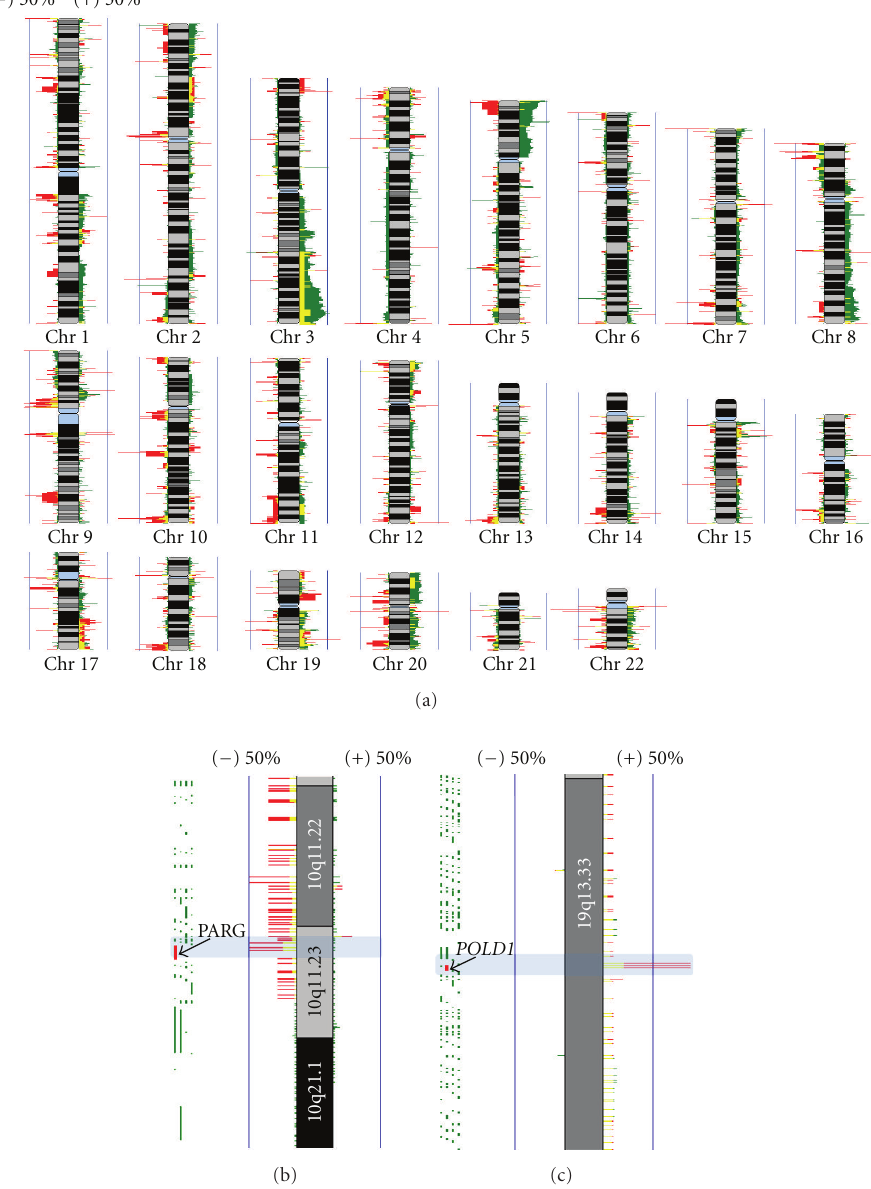
Figure 1: Genome-wide identification of arsenic-related and smoking independent DNA copy number alterations in lung squamous cell carcinoma (SqCC). Genomic copy number profiles for lung SqCC biopsies ( n = 52) were obtained using whole genome aCGH. SqCC tumors from smokers ( n = 42), comprised ( n = 30) samples from North American with no known arsenic exposure, and ( n = 12) samples from Northern Chile from individuals chronically exposed to arsenic. SqCC tumors from never smokers ( n = 10) were from chronically arsenic- exposed individuals from Northern Chile. (a) Frequency plot of arsenic-related and smoking independent copy number di ff erences in SqCC. The frequency of DNA gain/loss for each probe was calculated and plotted for each group, where smokers (dark green) and never smokers (red). Regions exhibiting similar alteration in both groups are denoted in yellow. The magnitude of green and red bars represents percent alteration for each probe per group (0–100%, with blue vertical lines representing 50% frequency). DNA gains and losses are represented to the right and left of each chromosome, respectively. Analysis was restricted to autosomes, with any di ff erences based on sex subtracted from further analysis. A high frequency of copy number alteration, previously undescribed for SqCC were evident in arsenic exposed tumors from never smokers, particularly for chromosome 3q. (b) Detail of DNA losses at 10q11.23 specific to never smokers are highlighted in a light-blue rectangle. PARG, previously shown to mediate cell death in response to genotoxic stimuli (PMID: 19571039), is indicated in red. (c) Recurrent DNA gain found in never smokers at 19q13.33. This segment contains the POLD1 gene, a DNA polymerase delta complex, involved in DNA replication and repair (red